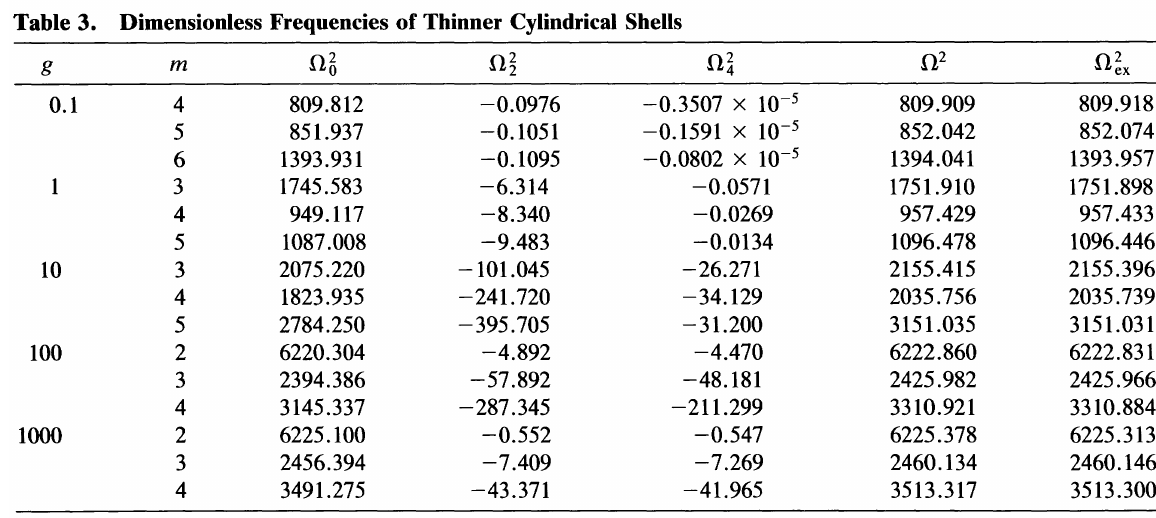
Table 3. Dimensionless Frequencies of Thinner Cylindrical